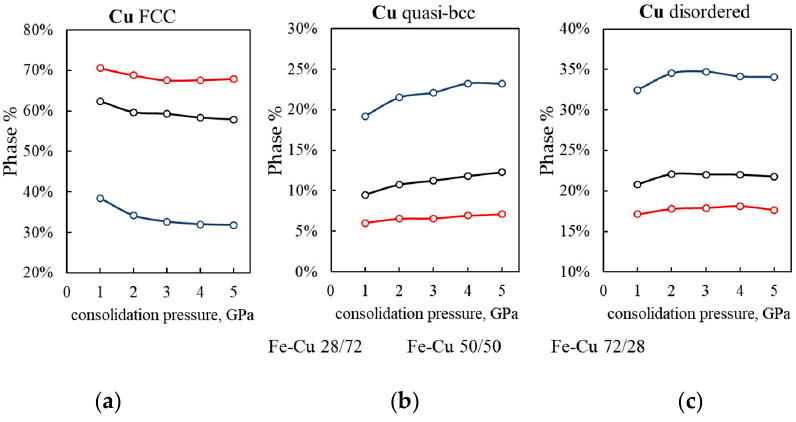
Figure 5. The calculated crystal structure of the Cu component – fcc ( a ), quasi-bcc ( b ) and disordered phase ( c ) as a function of consolidation pressure for three different Fe–Cu compositions: 28/72 (red), 50/50 (black), 72/28 (blue).